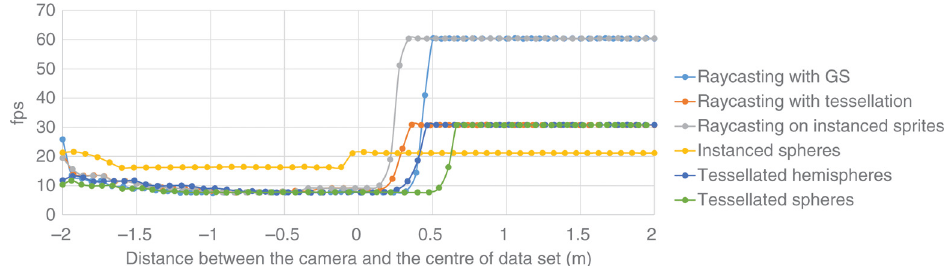
Figure 9: Frame rate over time while flying through 1AF6 starting at 2 m distance and ending 2 m behind the data set. The diagram for the same fly-through using 1TII looks quite similar. As the data sets become larger, the constant cost of vertex transformations is already too high to achieve 60 fps even if nothing is visible. From the pool of the data sets we tested, this is the case for A1F6 and all larger ones. Figure 9 shows that all techniques that require more than one vertex per atom and/or need more than three shader stages cannot reach more than 30 fps even if nothing is